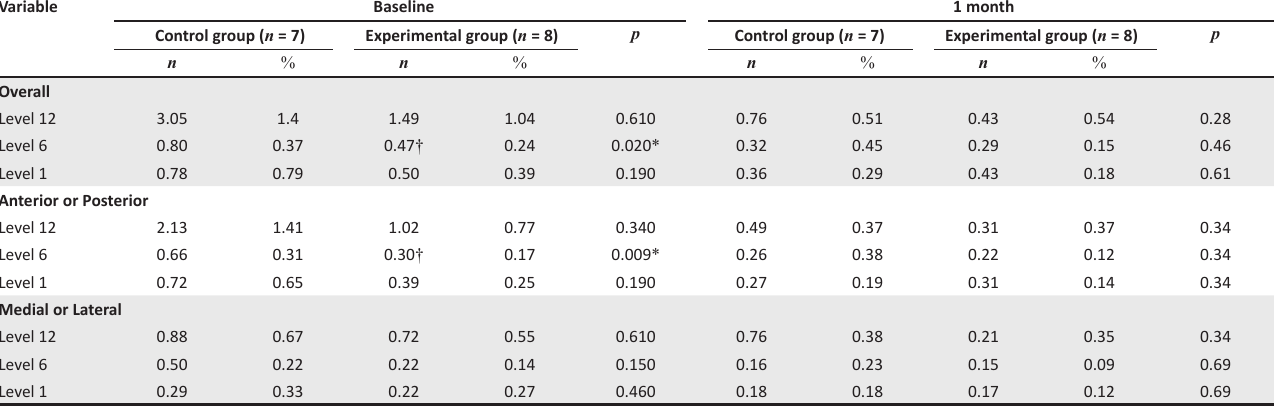
TABLE 3: Postural stability upper trunk at baseline and 1-month post-baseline ( n = 15). Variable